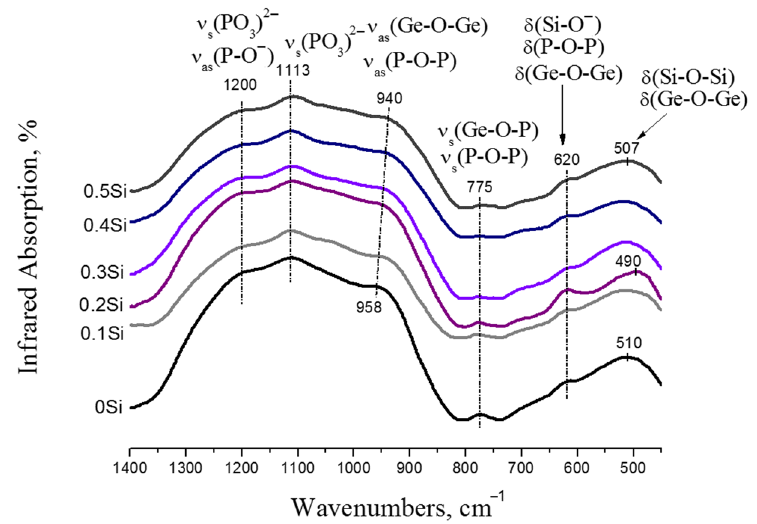
Figure 11. FT-IR spectra of 0Si–0.5Si glasses.